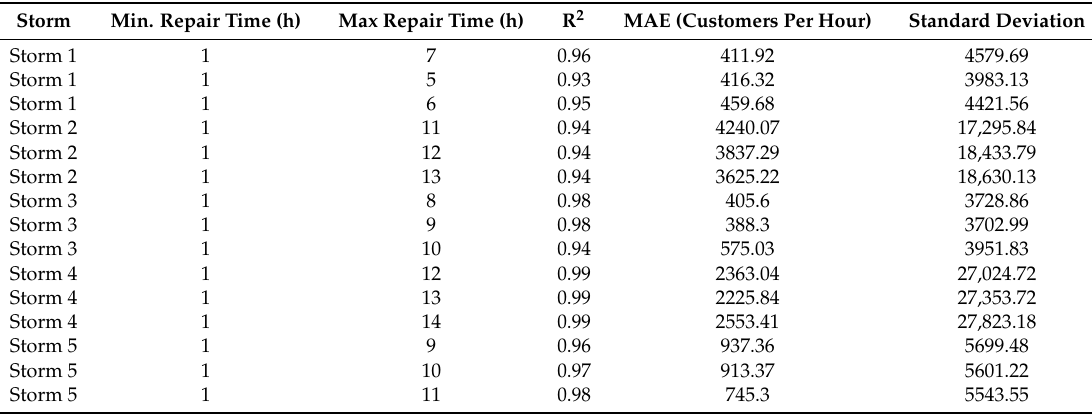
Figure 4. Varying maximum repair time for each validation storm. Crews start at random locations and search for nearest outage. Travel speed set to 25 mph, the total number of crews and percent working during each shift shown in Table 1. Maximum repair time varied from 1 to 15 h, as indicated. Number of outages and total customers affected for each storm shown in Table 1. Repair time ranges varied for each storm. The fit was not constant throughout the storm. Lower repair time ranges fit better early in restoration and longer repair time ranges fit better later in storm restoration. Table 3. R-squared, MAE and standard deviation of the top 3 combinations of modeled restoration curves from Figure